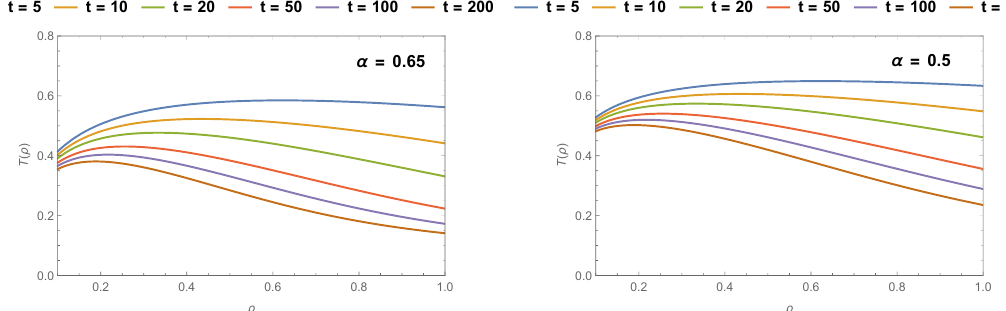
Figure 8. Comparison of drying kinetics with Lewis generalized fractional model under different finite times, k αρ = 0.24, Y 0 = 1, Y e = 0.09.